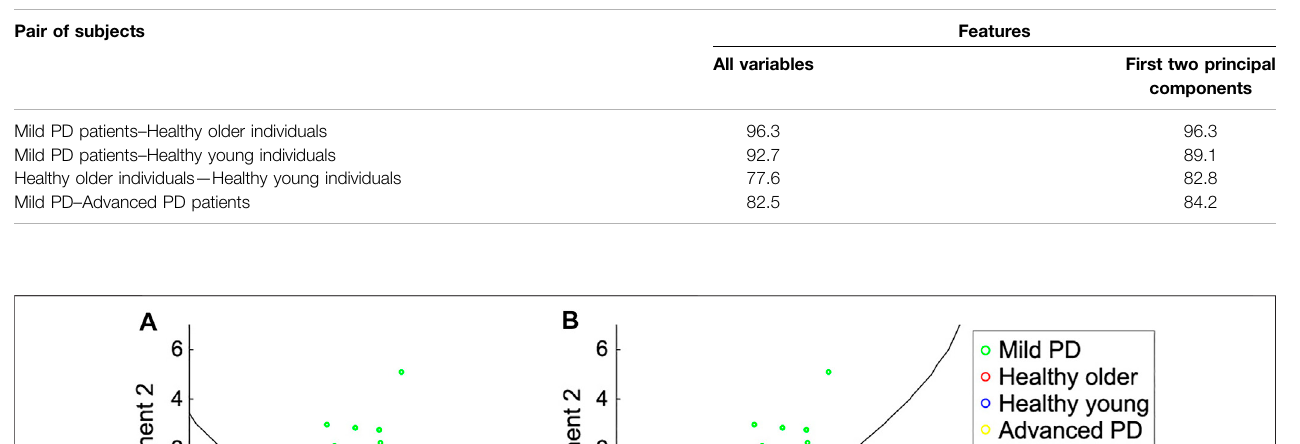
TABLE 2 | Distinguishing accuracy (in percentages).